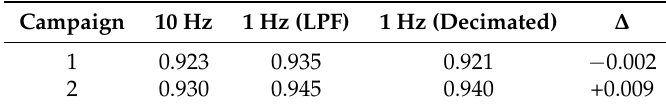
Table 3. Average ρ max in the coexistent Pisa traces before and after LPF/decimation.